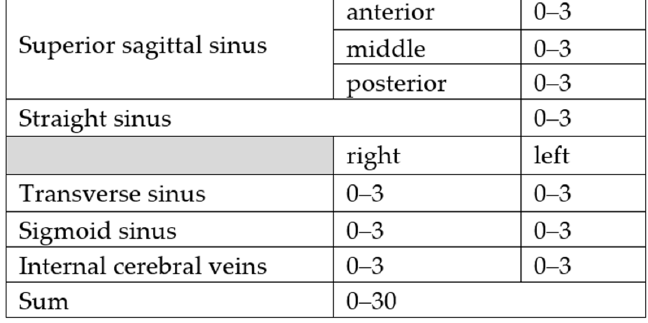
Figure 1. Cerebral venous system divided into 10 anatomical regions.